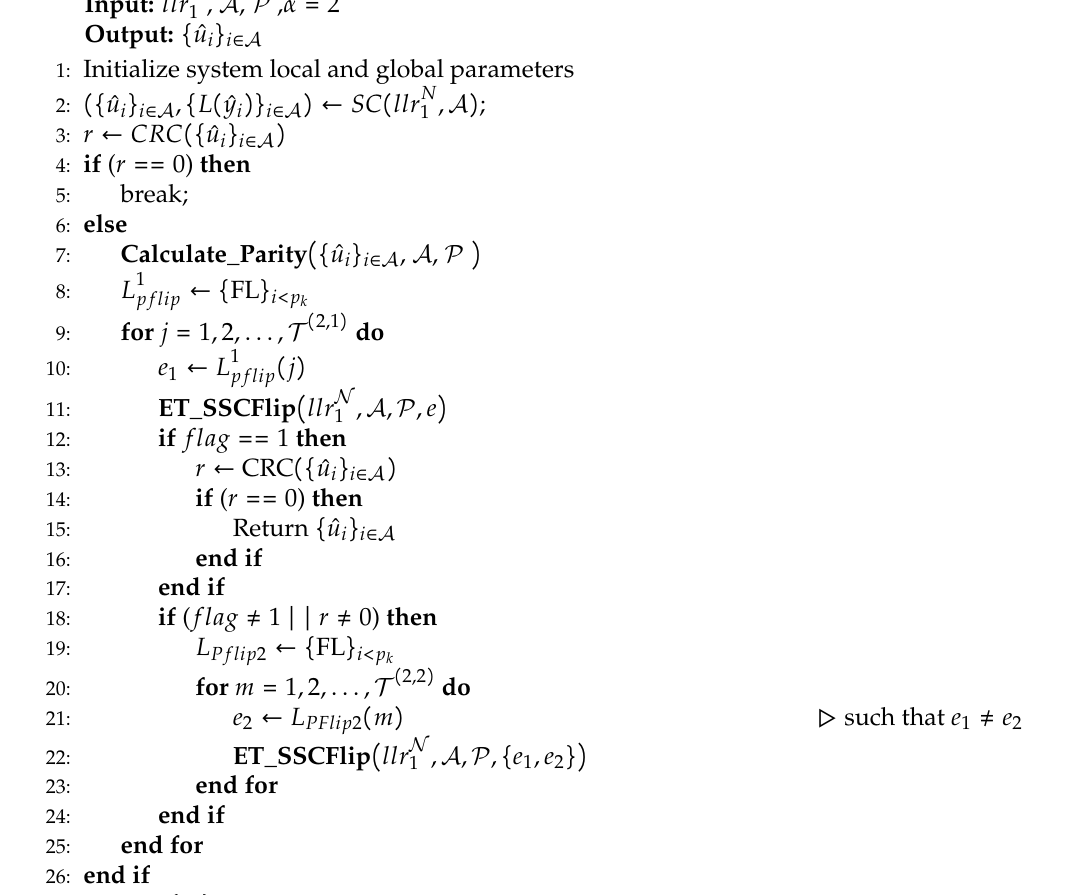
Algorithm 4 Two bits flipping PC-CRC-SSCFlip